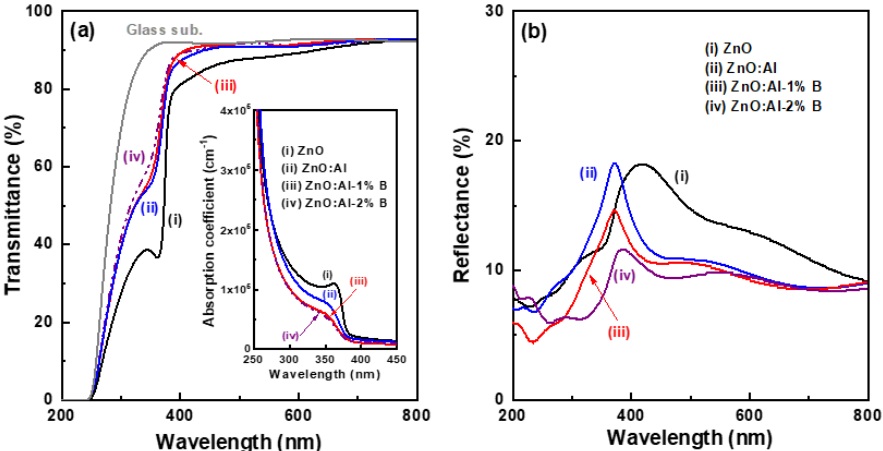
Figure 5. ( a ) Optical transmittance spectra and ( b ) optical reflectance spectra of the prepared ZnO, ZnO:Al and ZnO:Al-B thin film samples. The inset of Figure ( a ) shows the plot of absorption coefficient varied with wavelength in the near-UV region.